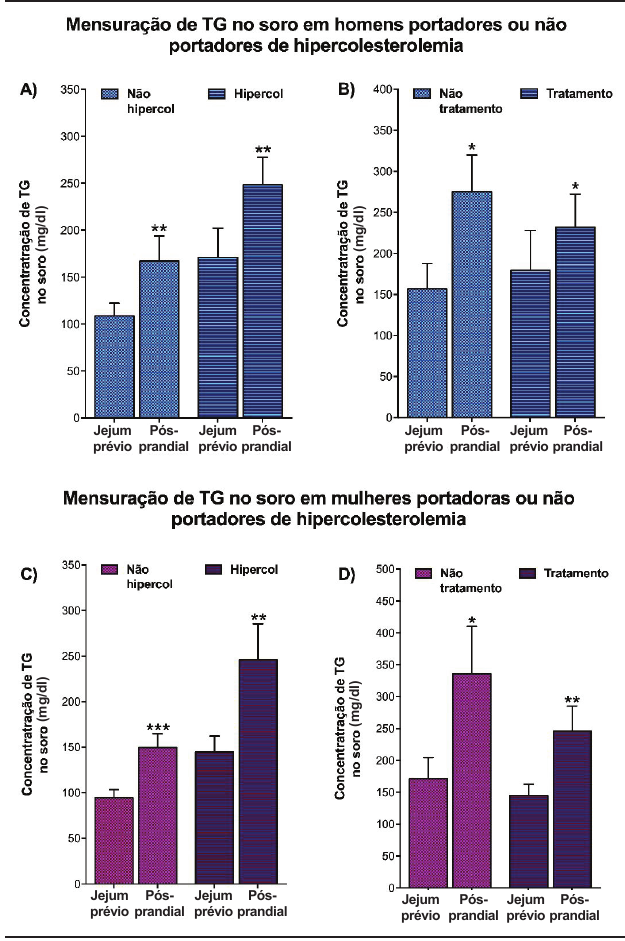
Figura 2 − Concentração de TG no soro de indivíduos portadores e não portadores de hipercolesterolemia mensurada após jejum prévio de 12 horas e de forma